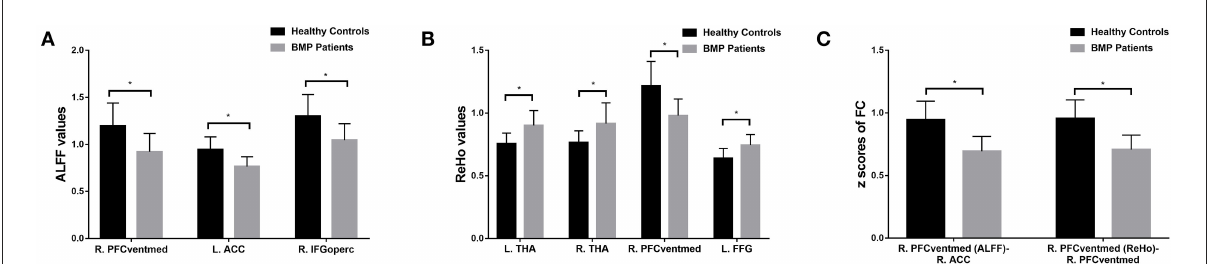
FIGURE2 Brain regions with significant differences in ALFF (A) , ReHo (B) , and FC (C) between BMP patients and healthy controls. * p < 0.05 (corrected with Gaussian random-field theory, voxel level p < 0.001, cluster level p < 0.05). ALFF, amplitude of low-frequency fluctuations; ReHo,